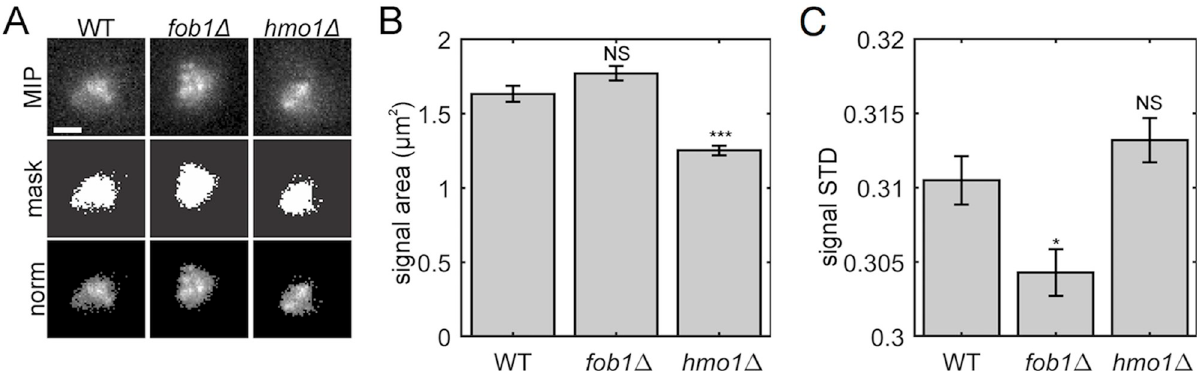
Fig 2. Experimental images of the nucleolus. Algorithmic thresholding of CDC14-GFP reveals alterations in nucleolar area and variance of signal intensity. (A) Top row depicts images of maximum intensity projection of WT, fob1 Δ , and hmo1 Δ yeast cells containing CDC14-GFP to label the nucleolus. Scale bar is 1 μ m. The middle row are images of the binary mask generated by thresholding the projections using Otsu’s method. The bottom row are images of the projections where the intensities of pixels below the threshold were set to zero. See Methods Section: Image acquisition and baseline processing for more detail. (B) Bar chart of the nucleolar signal calculated by the area of the binary mask. (C) Bar chart of the standard deviation of normalized nucleolar signal. In panels (B) and (C), the non-significant changes are labeled ‘NS’ (see text), the bars represent an average value across n cells, and error bars indicate standard